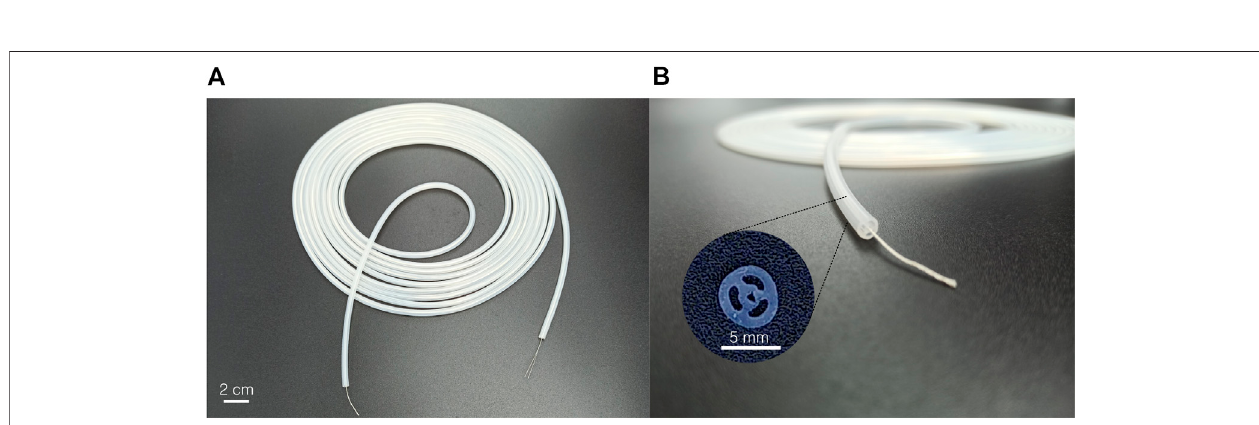
FIGURE 3 | Industrially extruded hardness 40A silicone sample. (A) The 5 m long silicone tube is coextruded around a central thread. (B) The cross-section respects the dimension but shows small imperfections.